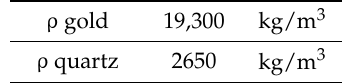
Table A2. Quartz and gold